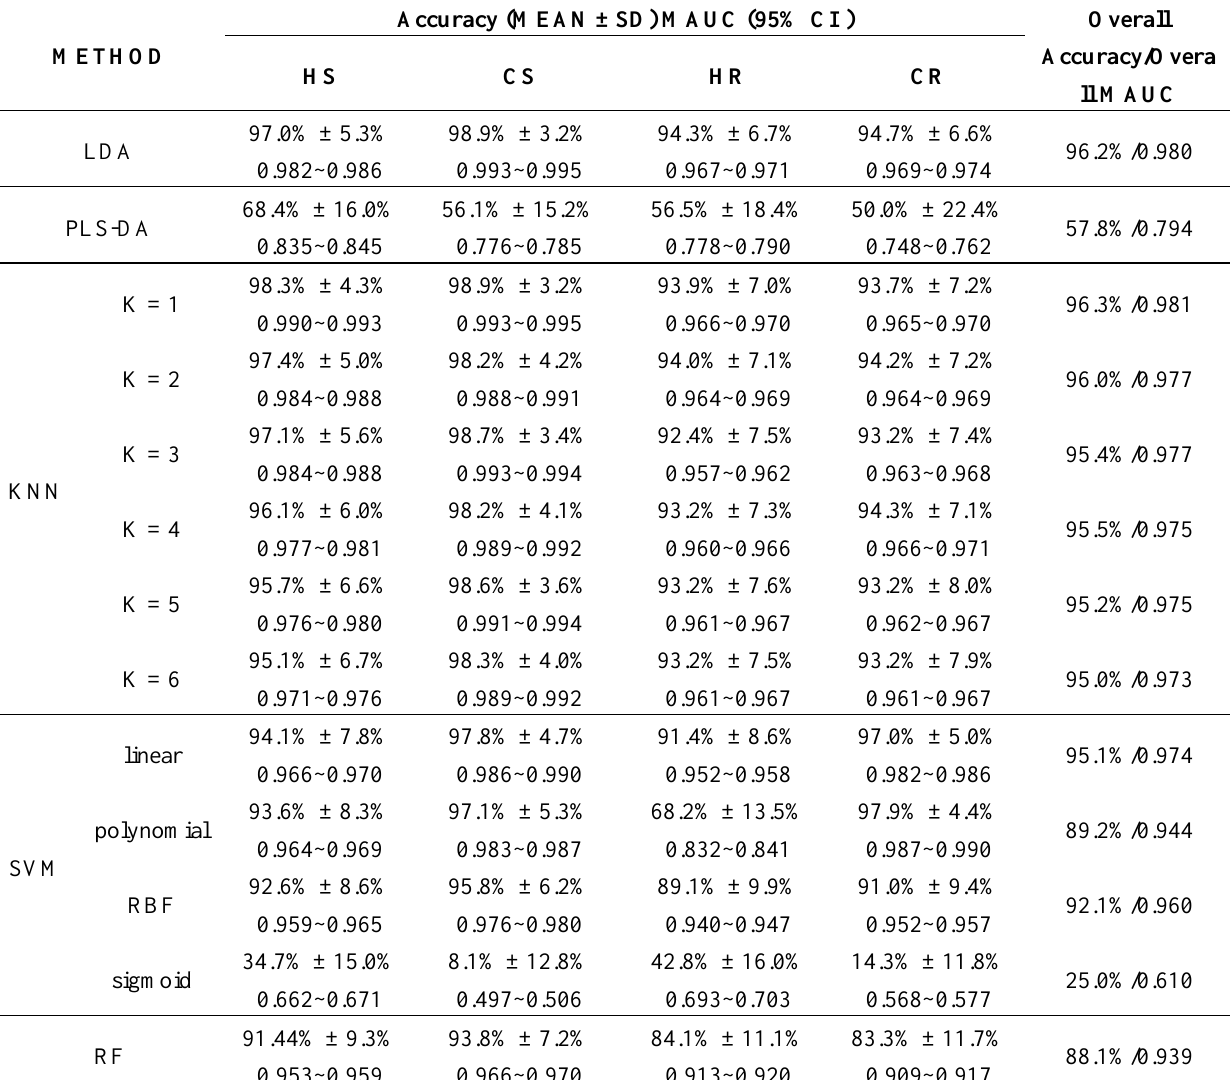
Table 4. Comparison of accuracy and MAUC among five classification methods, based on 1000 runs of k-fold (k = 10)